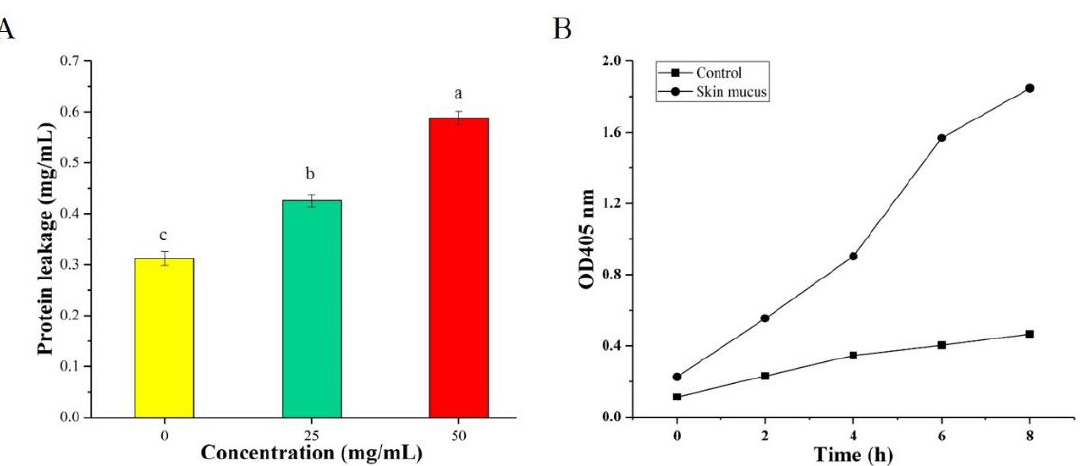
Figure 2. Effect of the skin mucus extract of C. argus on the cell membrane permeability of the tested S. aureus : ( A ) leakage of protein from S. aureus treated with the skin mucus extract; ( B ) the release of cytoplasmic β -galactosidase from S. aureus bacteria after treated with the skin mucus extract. Letters (a, b and c) indicated the significance between each group.